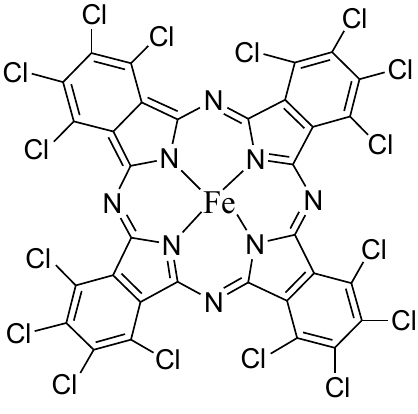
Figure 1. The molecular structure of Cl